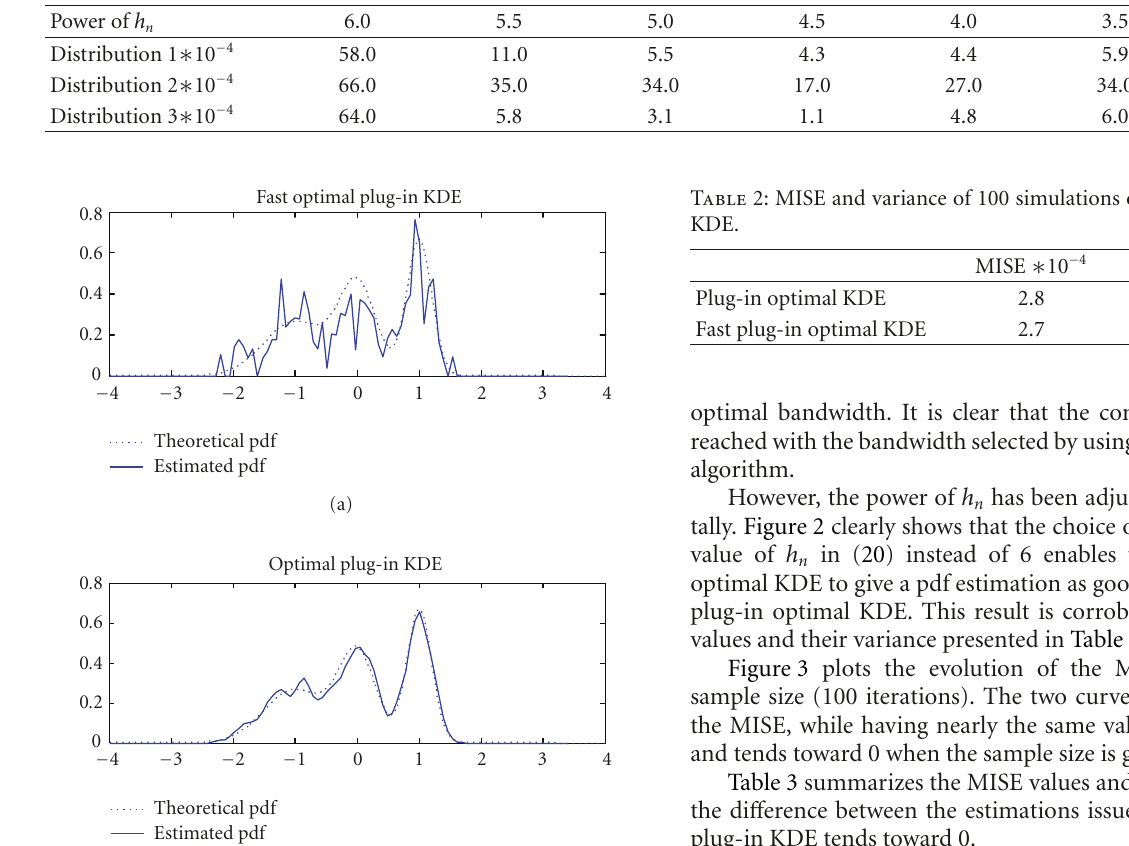
Table 1: MISE versus power of h n for three selected distributions.